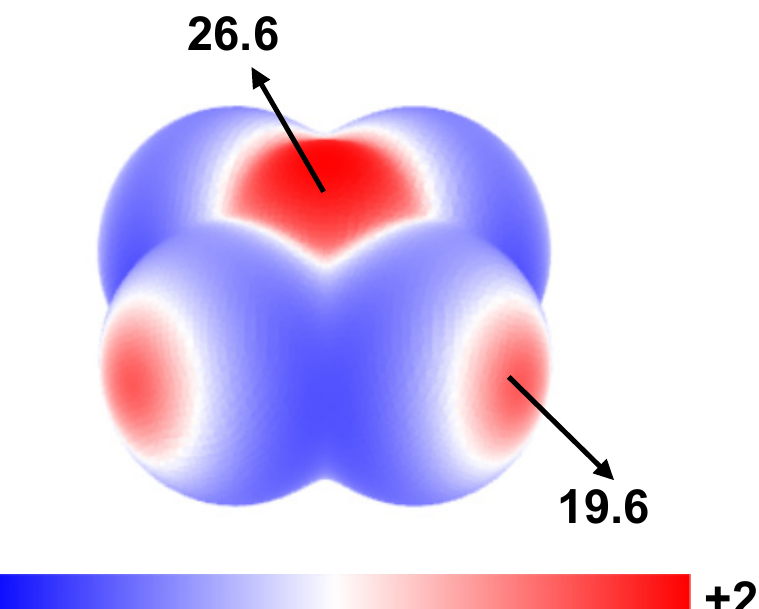
Figure 2. ESP on surface ( ρ = 0.001 a.u.) for tbe in kcal/mol.